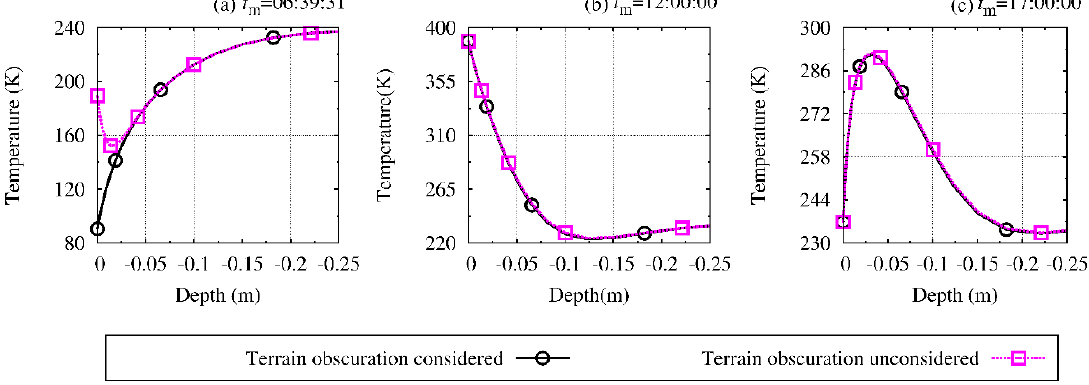
Figure 5. Profile of temperature–depth with (solid black line with circle) and without (dashed pink line with square) terrain obscuration. The panels ( a ) and ( b ) denote profiles at the lunar time t m = 06:39:31 and t m = 12:00:00, respectively, and ( c ) represents that at t m = 17:00:00. Figure 5 denotew profiles of temperature–depth at the lunar local time tm = 06:39:31, tm = 12:00:00, and tm = 17:00:00. The solid black line with circle signifies temperature variation with terrain obscuration, while the dashed pink line with square represents the case without terrain obscuration.